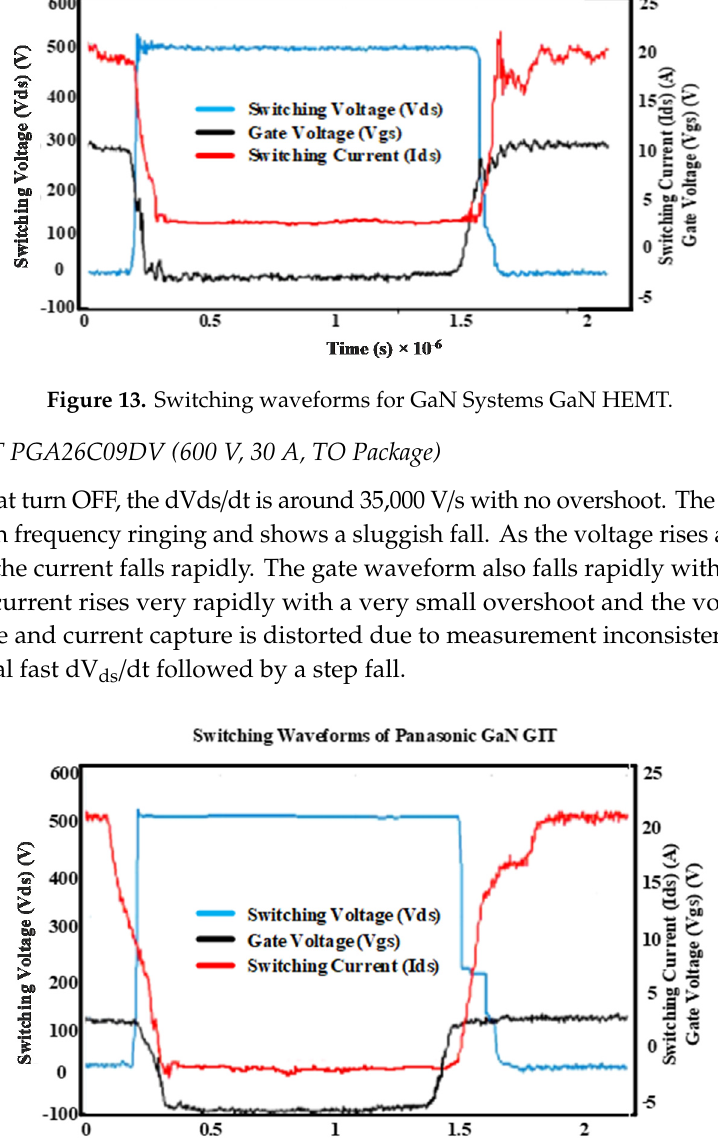
Figure 15. Switching waveforms for the Transphorm GaN HEMT cascode. 5. Simulation of the Double Pulse Tests Using the Proposed Model and Manufacturer Model For this research, the proposed behavioural model was demonstrated and validated by redesigning the LT-Spice model provided by the manufacturer. The parameters of the existing model were customised to bring the model into alignment with the extracted measurements. Figure 16a,b is a replication of the simplified zero bias model of Figure 7. The manufacturer and proposed models are both simulated in LT-Spice for comparison, as shown in Figure 16.